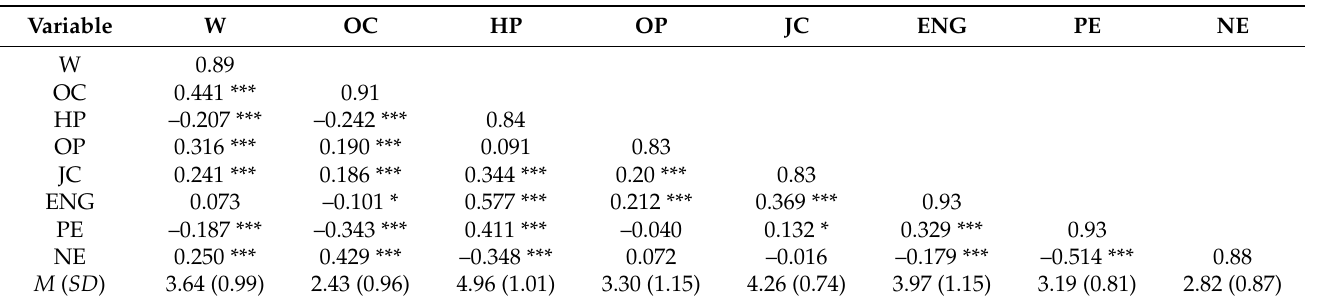
Table 1. Descriptive statistics and scale